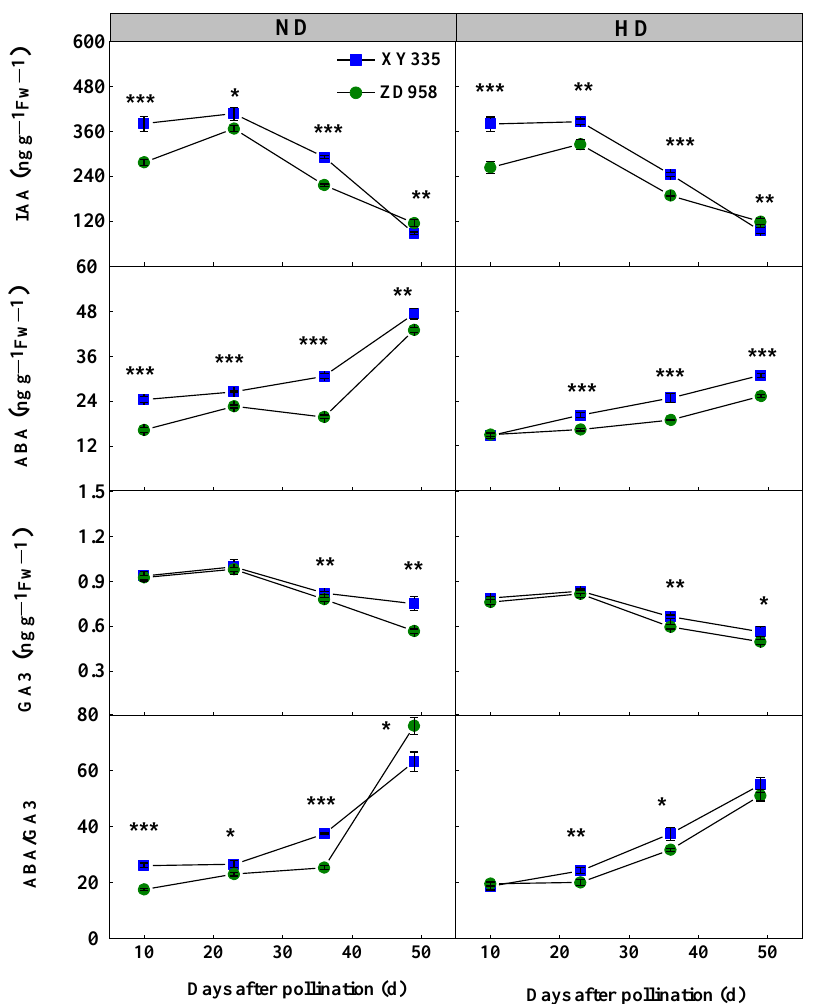
Figure 6. Effect of plant density on indole-acetic acid (IAA), abscisic acid (ABA), and gibberellic acid (GA 3 ) contents in grain between two maize hybrids in 2018 growth season. ND and HD indicate 60,000 and 90,000 plants ha − 1 density, *, ** and *** indicate significant difference at p < 0.05, p < 0.01 and p < 0.001, respectively. Bars denote standard error ( n = 3).